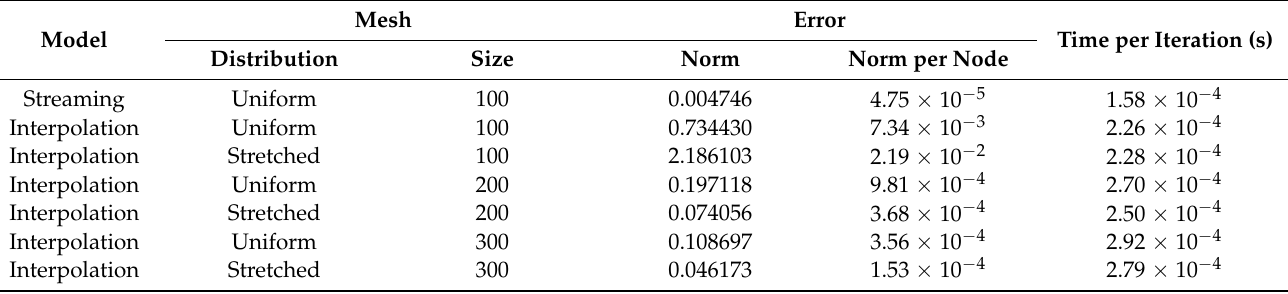
Table 1. Error and computational cost of the diffusion